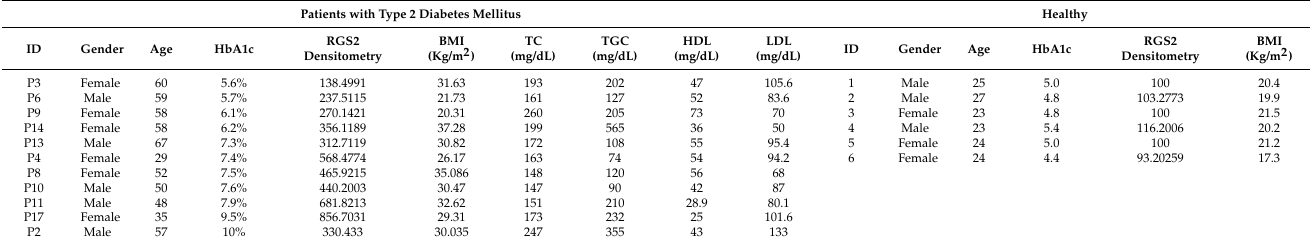
Table 1. Body Characteristics and Serum Blood Levels for Different Tests in T2DM Subjects.